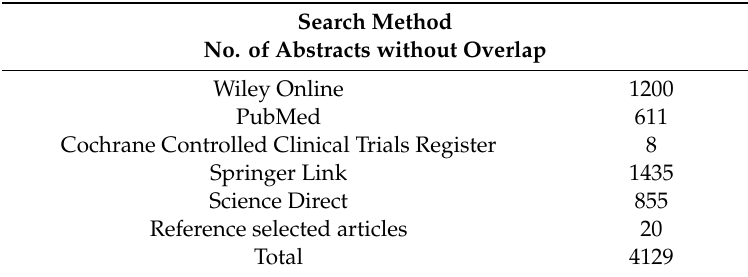
Table 2. Abstracts Retrieved by Electronic, Manual and Reference